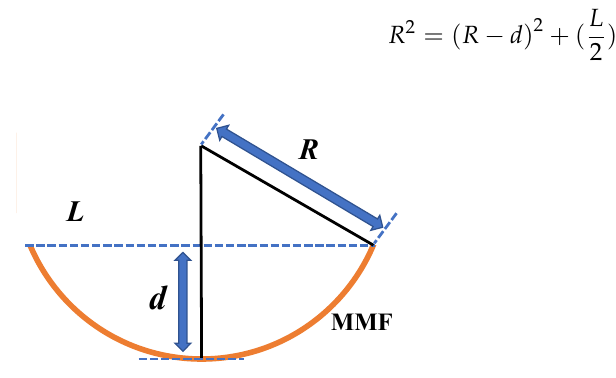
Figure 3. Graphical representation of the curvature radius R .